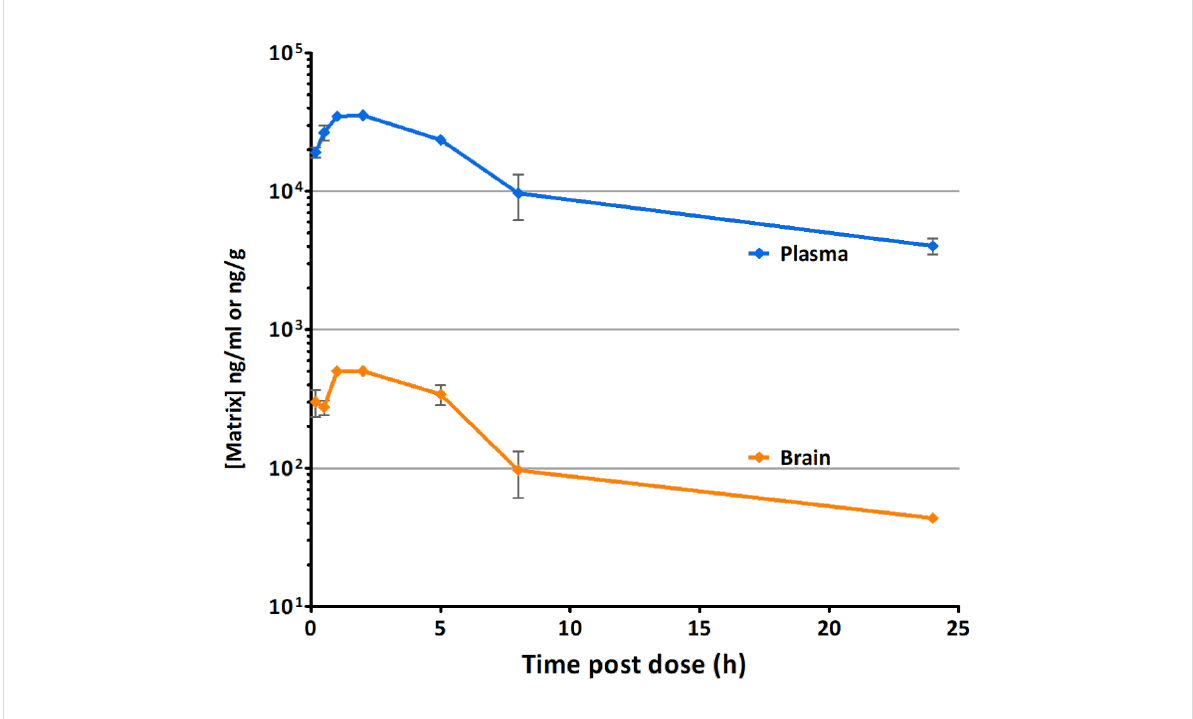
Figure 2: Concentrations of 1 in mouse following oral administration (p.o.) at 10 mg/kg.